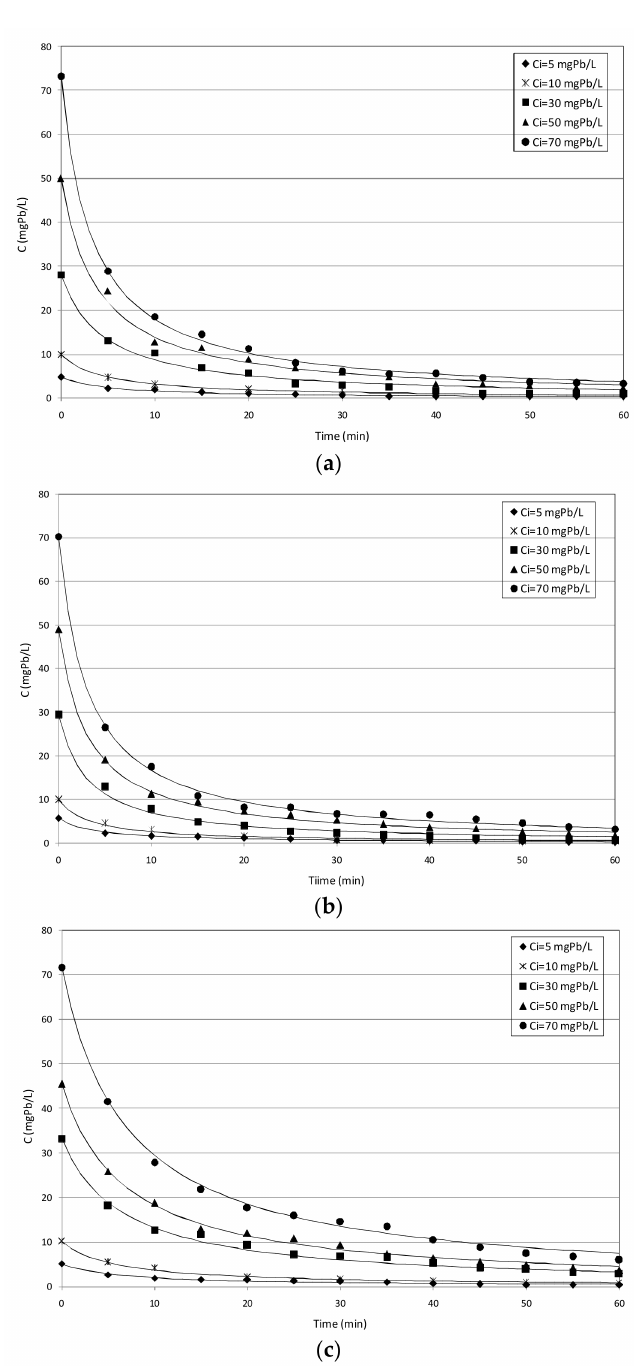
Figure 7. Pb 2+ concentrations (C) detected during the tests conducted with MgO_nNZVI and different initial lead concentrations (C i ) at initial pH levels of 3 ( a ), 5 ( b ), and 7 ( c ). The continuous trends represent the modeling curves obtained by a second-order kinetic law. The R 2 between the experimental values and the modeling curves were always higher than